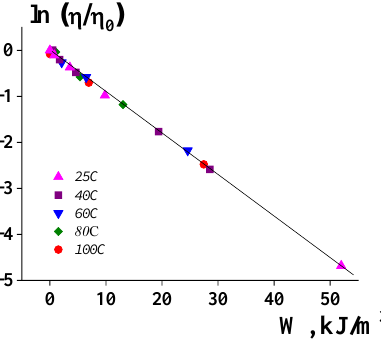
Figure 2. Dependence of the non-Newtonian effect of a polyisobutylene on the stored elastic energy at different temperatures [10].